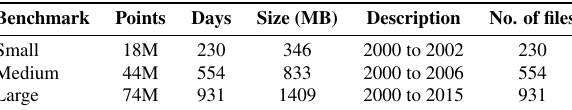
Table 2: Benchmark stages of the Sand Engine use case. The size represents the size of the LAZ files in the filesystem.